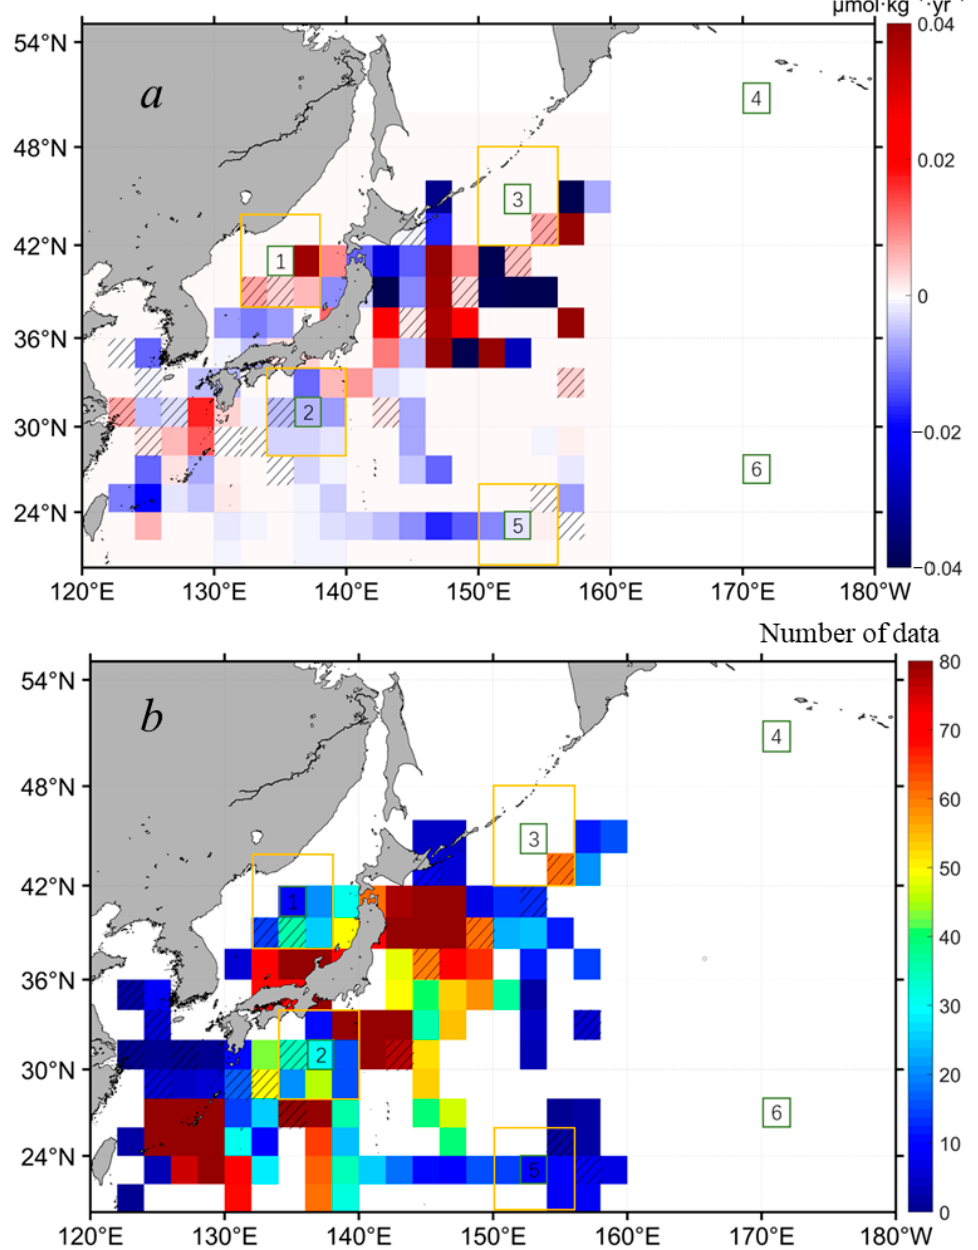
Figure 8. ( a ) The spatial distribution of the interannual changing rates of SSN in the northwest Pacific, based on the monthly means of in situ SSN with a grid size of 2° × 2° in the period of 1980– 2020 (see Section 2.3 for more details). Warm colors suggest positive trends and cold colors suggest negative trends. Note that pixels with cross lines mean insignificant statistics at p > 0.05, and pixels in white mean that no data are available. ( b ) The number of monthly data used to calculate the interannual changing rates of SSN in ( a ). The six subregions outlined in a 2° × 2° box (i.e., boxes of 1–6 outlined in green) are the same as those shown in Figure 5. The SSN anomalies within the yellow boxes around the subregions of 1, 2, 3, and 5 were extracted for statistical measures of correlations with the associated Chl-a anomalies.